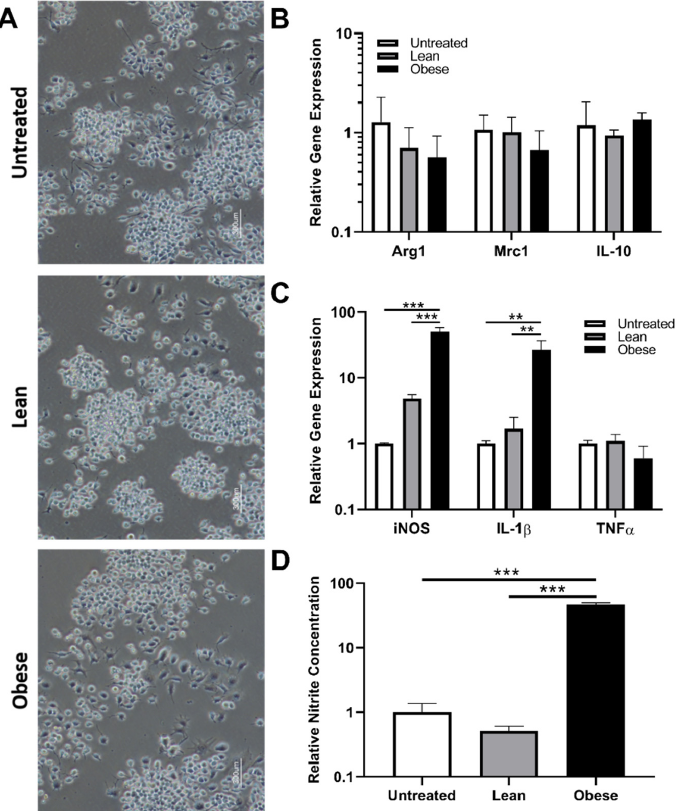
Figure 2. RAW264.7 cells following indirect co-culture with ASCs in a Transwell system. ( A ) Representative images of RAW264.7 morphology following either LnASC or ObASC co-culture for 48-h. ( B ) Changes in anti-inflammatory gene expression of RAW264.7 cells following 48-h co-culture relative to untreated controls. ( C ) Changes in pro-inflammatory gene expression of RAW264.7 cells following 48-h co-culture relative to untreated controls. ( D ) Griess assay determination of nitrite concentration of 48-h conditioned media following 48-h co-culture relative to untreated controls. Values are presented as means (N = 3) ± SD of three independent experiments using one-way ANOVA followed by Dunnett’s multiple comparisons test. Statistical differences between the means are marked with ** p < 0.01, *** p < 0.001. Abbreviations: Arg1, arginase 1; Mrc1, mannose receptor C-type 1; IL-10, interleukin 10; iNOS, inducible nitric oxide synthase; IL-1 β , interleukin 1 beta; TNF α , tumor necrosis factor